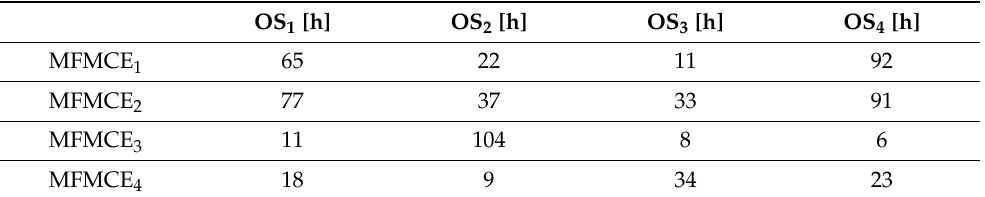
Table 2. Cross combination after row minima